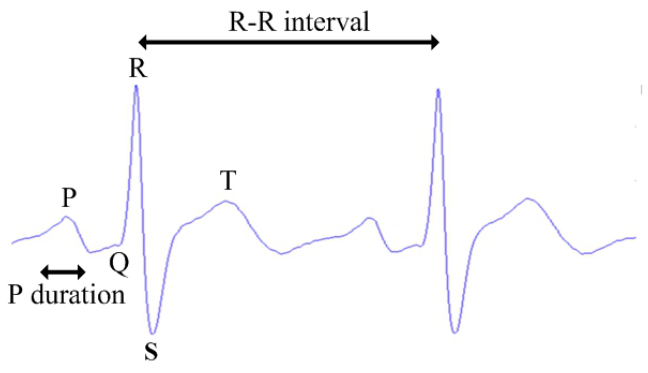
Figure 3. ECG characteristics.